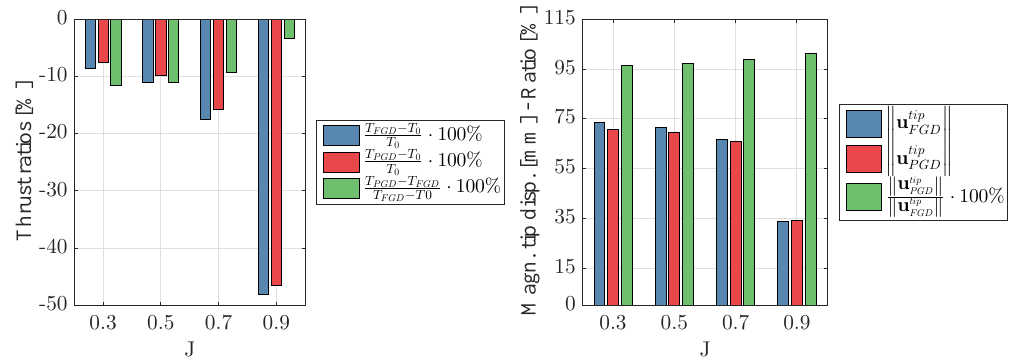
Figure 10. Blade thrust ( left ) and tip displacement ( right ) results obtained with the FGD- and PGD-BEM model for various advance ratios. The subscripts FGD and PGD indicate with which BEM model the results were obtained.